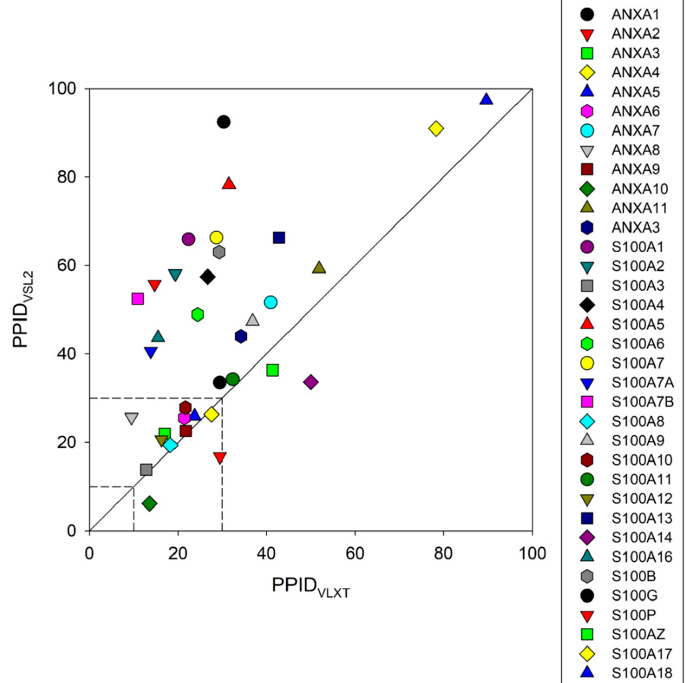
Figure 8. 2D representation of the results of evaluation of disorder levels of human annexin and S100 proteins. Here, the percentages of residues in these proteins predicted to be disordered by PONDR ® VSL2 are compared with their percentages of disordered residues predicted by PONDR ® VLXT. The goal of this plot is to show the overall agreement between the outputs of different disorder predictors used in this study and to show high level of disorder in analyzed proteins.